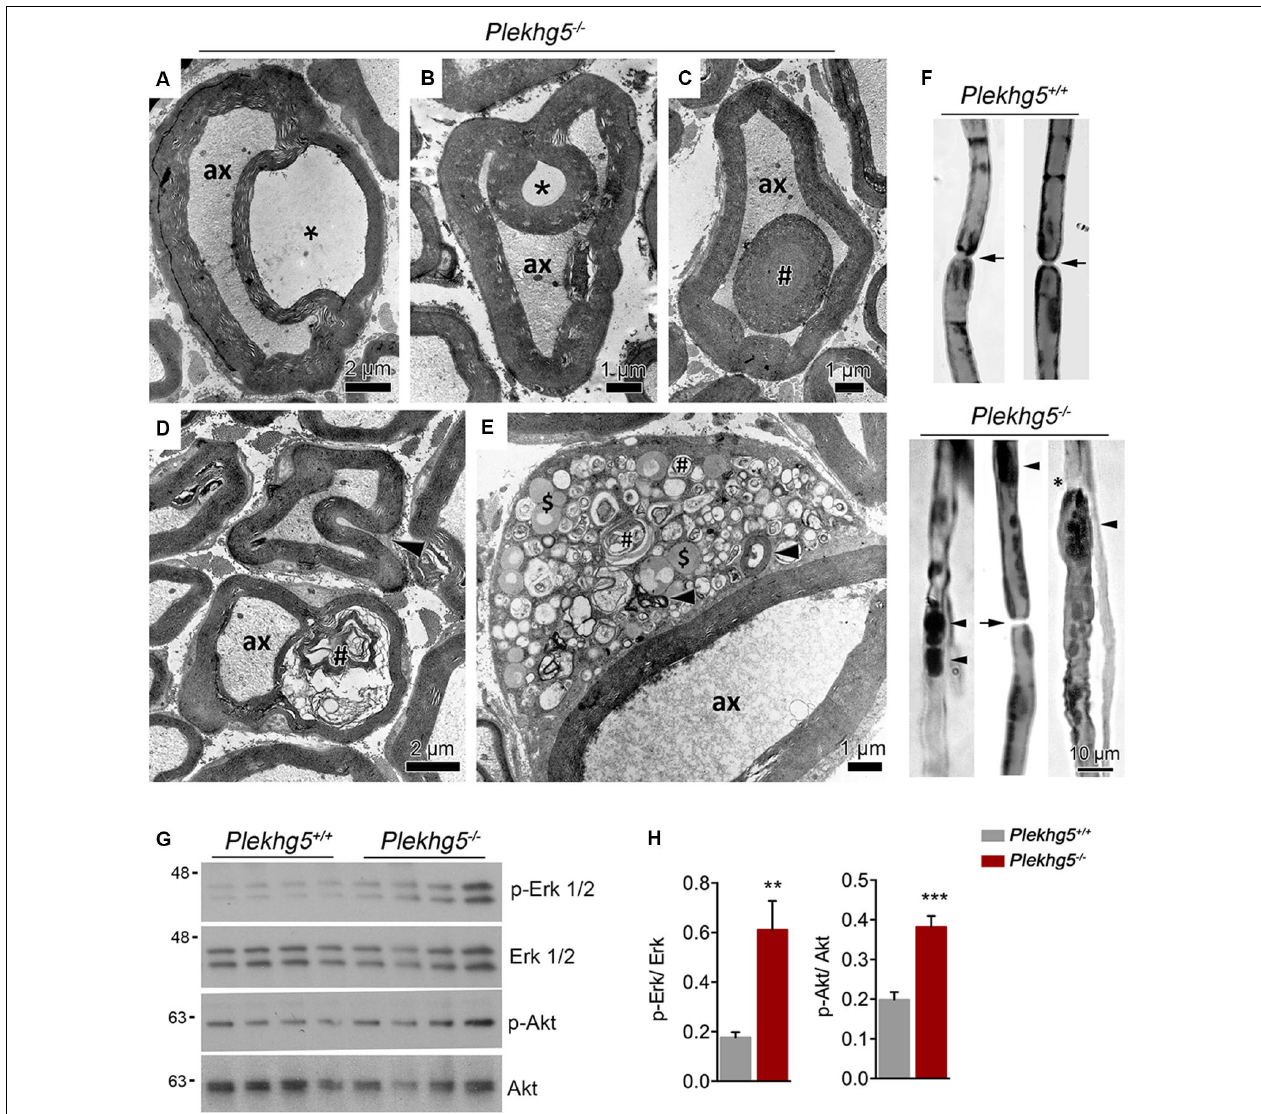
FIGURE 2 | Ultrastructural analysis of sciatic nerve. (A–C) Electron micrographs of Plekhg5 -deficient mice depicting severe pathological features as splitting of myelin sheath (A) , myelin infoldings (B,D) , and an internal myelin ring within the myelinated axon (# in C ). Asterisk highlights the lack of axonal or cytosolic structures (e.g., neurofilaments, organelles, etc.) within myelin infoldings. ax = axon; scale bar: 2 µ m (A,D) , 1 µ m (B,C,E) . (D) Partly disrupted myelin sheath (#) containing myelin debris; note beginning infolding myelin sheath (arrowhead). (E) Schwann cell soma with myelin debris (arrowheads), accumulations of vesicles from putatively the autophagosomal (#), and endolysosomal ($) compartment. (F) Teased nerve fiber preparation, lipids visualized (=dark staining) by treatment with osmium tetroxide. Arrows point to node of Ranvier, arrowheads to myelin accumulations, note irregular outline in (E) and apparent blunt nerve ending (*). Scale bar: 10 µ m. (G) Western blot analysis of Erk1/2 and Akt signaling in sciatic nerve lysates obtained from 11-month-old mice. (H) Quantification of Western blots [ n = 5/4 (wild-type/ko), unpaired, two-tailed t -test]. ** p < 0.01; *** p < 0.001.